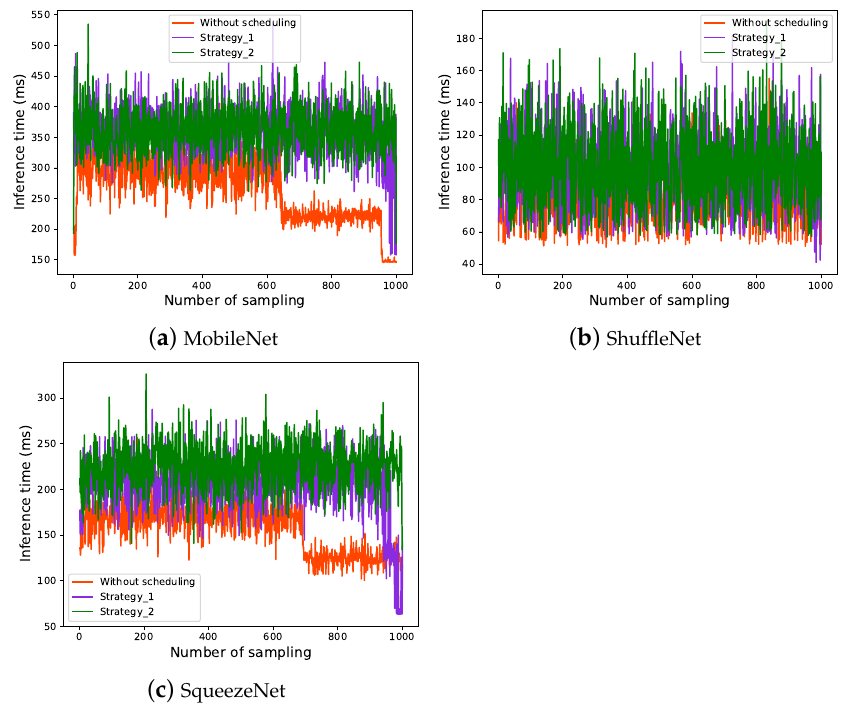
Figure 13. The inference time of the three